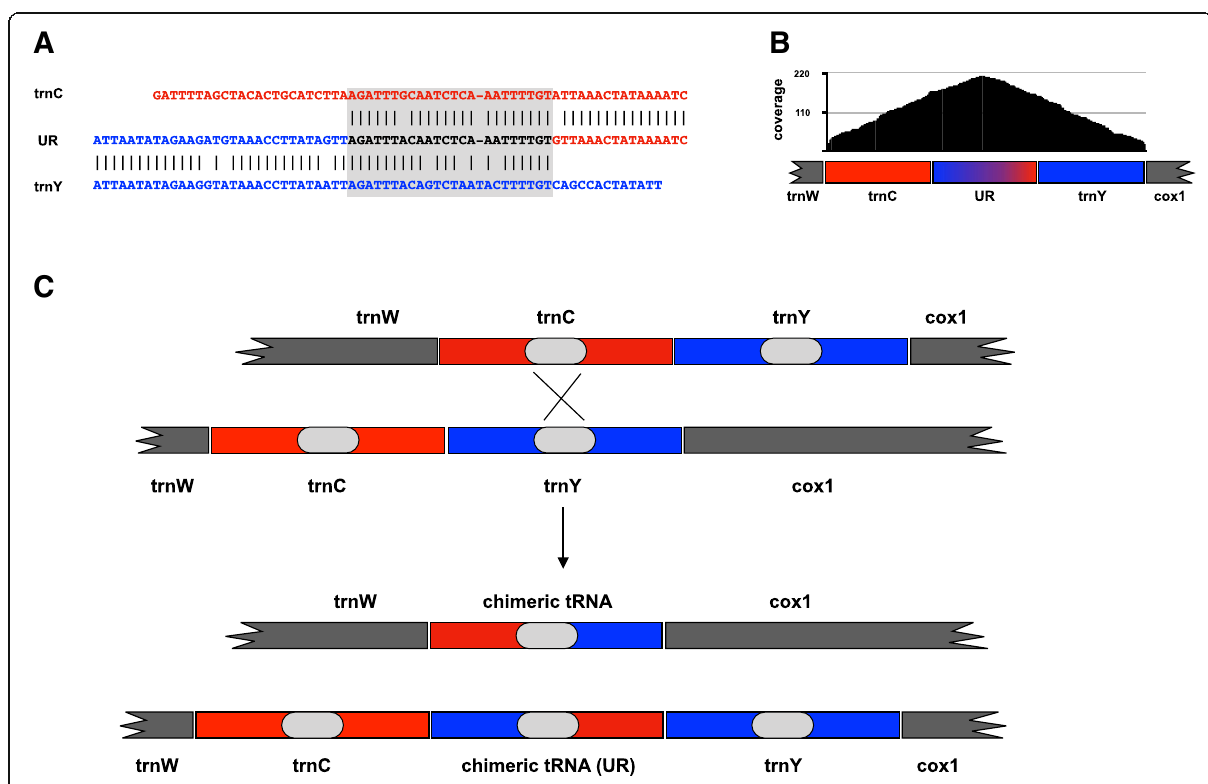
Fig. 2 Lepidurus apus lubbocki unassigned region (UR) sequence analysis. a Alignment of UR with flanking tRNAs; the grey shaded area indicates the region of high similarity between trnC and trnY . b Coverage of the UR obtained by reads mapping. c Schematic drawing of the hypothesized non-homologous recombination originating the observed